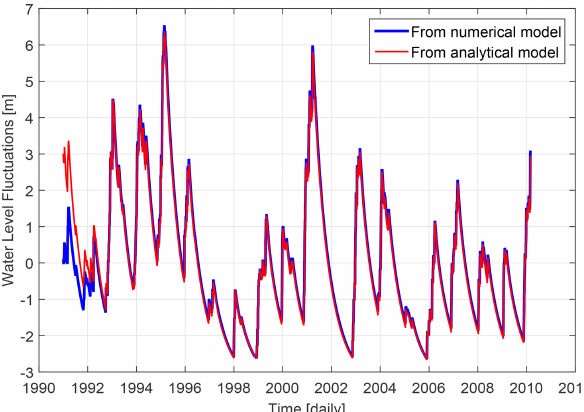
Figure B1. Comparison of water table fluctuations, at x = 1500m, obtained from analytical and numerical models. Note that the steady-state term (the mean value) has been